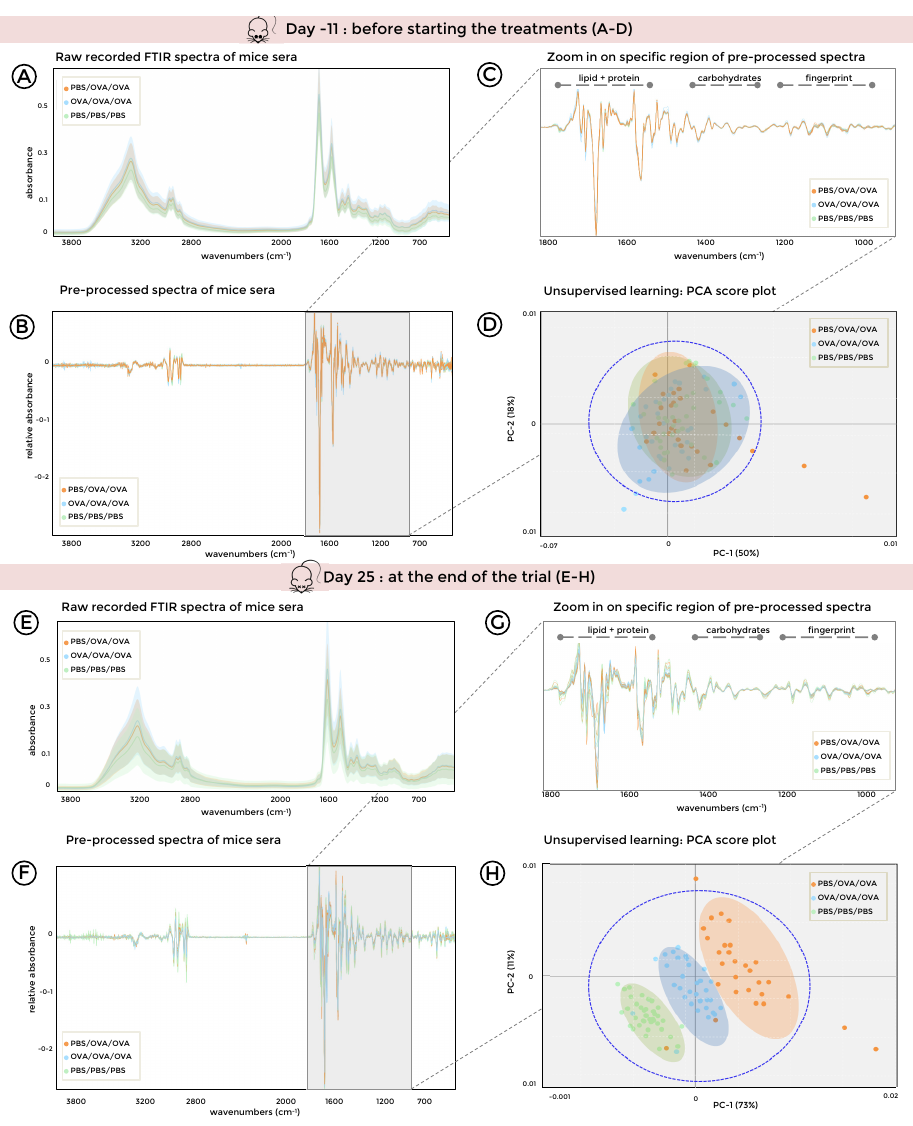
Figure 4. Principal component analysis (PCA) of Fourier-Transform Infrared (FTIR) spectra from sera stratifies healthy, allergic, and tolerized mice. ( A – D ), Mouse sera were collected on –11 prior to treatments and ( E – H ), on day 25 at the end of the trial. (green: PBS / PBS / PBS; orange: PBS / OVA / OVA; and blue: OVA / OVA / OVA). FTIR spectra are shown as ( A , E ), unprocessed, and ( B , F ), pre-processed with wavenumbers selected for comparison highlighted in grey. ( C , G ), significant biomolecule regions. ( D , H ), PCA score plots; principal components (PC-1 and PC-2) within 95% confidence ellipse. OVA, ovalbumin; PBS, phosphate-bu ff ered